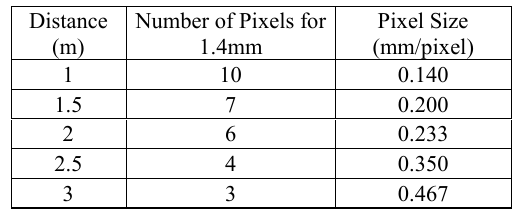
Table 4. The calculated pixel sizes.